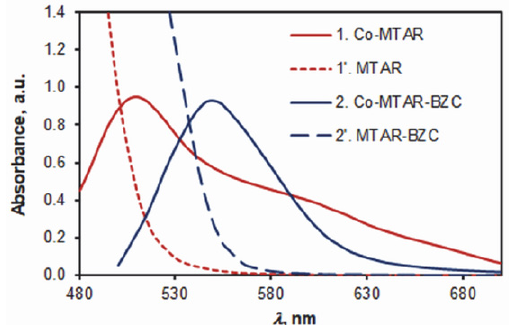
Figure 2. Absorption spectra in chloroform of the Co-MTAR binary complex (1) against blank (1’) and Co-MTAR-BZC ternary complex (2) against corresponding blank (2’). c Co = 4 × 10 −5 mol dm −3 ; t ex = 3 min; c